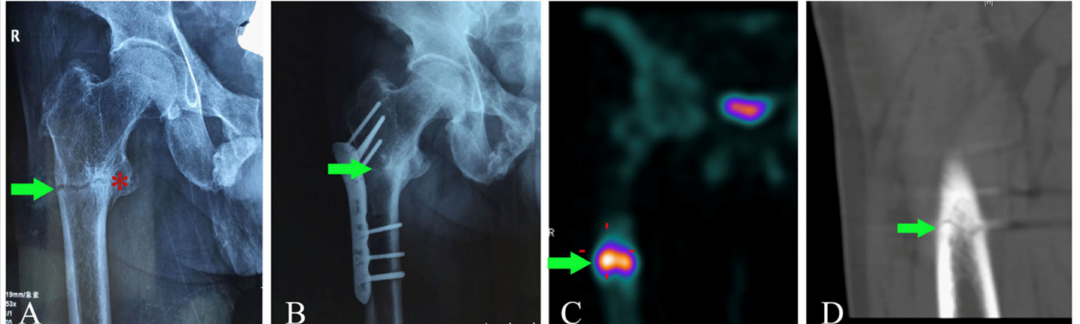
Figure 3. ( A ): Transverse fracture line of the proximal femur, with callus formation (star) as well as cortex breakage (arrow) simultaneously. ( B ): Successful healing of the primary pseudofracture of the proximal femur (arrow). ( C ): High uptake of 99mTc-MDP beneath the osteosynthesis plate, indicating a new pseudofracture of the proximal femur (arrow). ( D ): The transverse fracture line (arrow) revealed by computed tomography scanning (as reproduced with permission from ref.